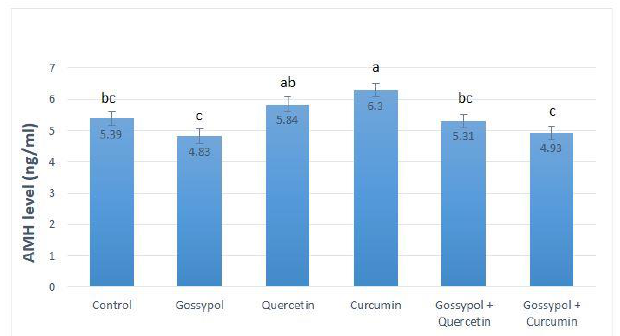
Fig. 4: The effect of treatment with gossypol, quercetin, curcumin, gossypol + quercetin and gossypol + curcumin on AMH level in serum (mean ± standard error). Similar letters indicate no significant differences between groups at (P > 0.05), while different letters indicate a significant difference between groups at (P <